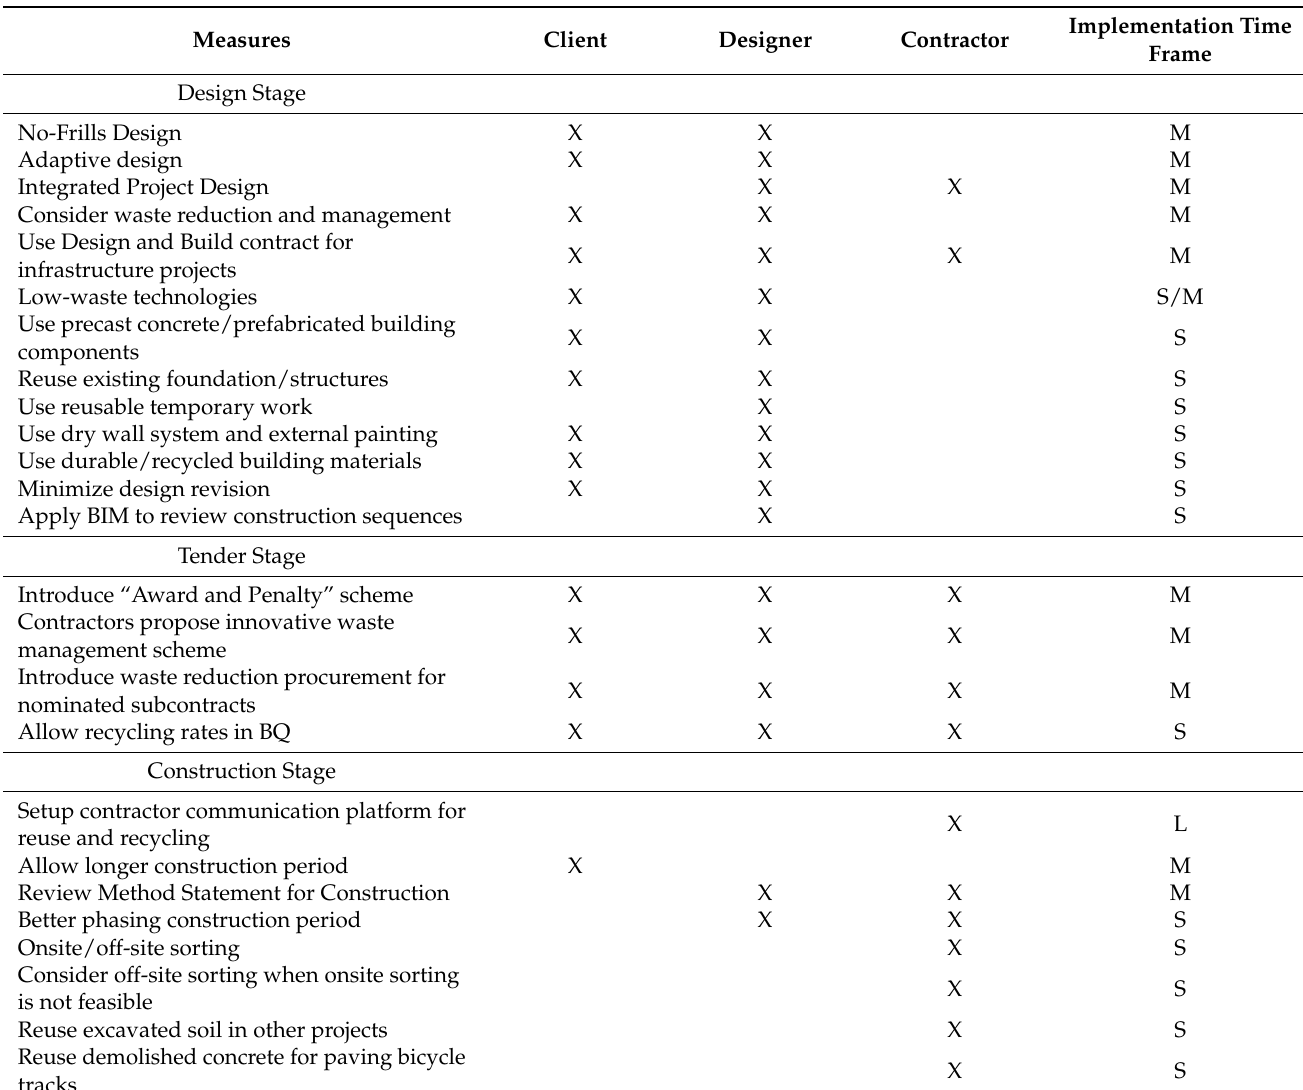
Table 4. Proposed strategies for construction